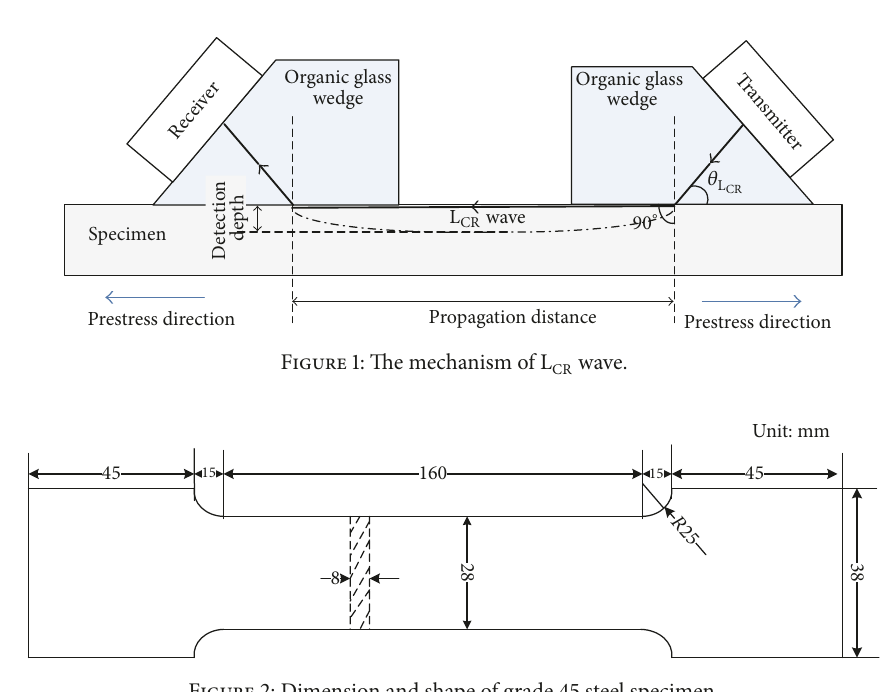
Figure 2: Dimension and shape of grade 45 steel